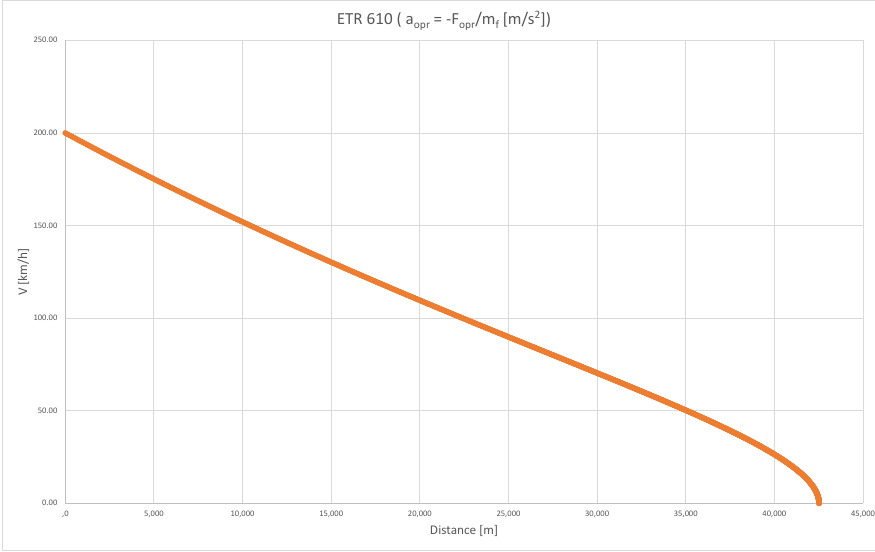
Figure 5. Braking characteristics due to resistance to motion of the ETR610 (ED250) train.